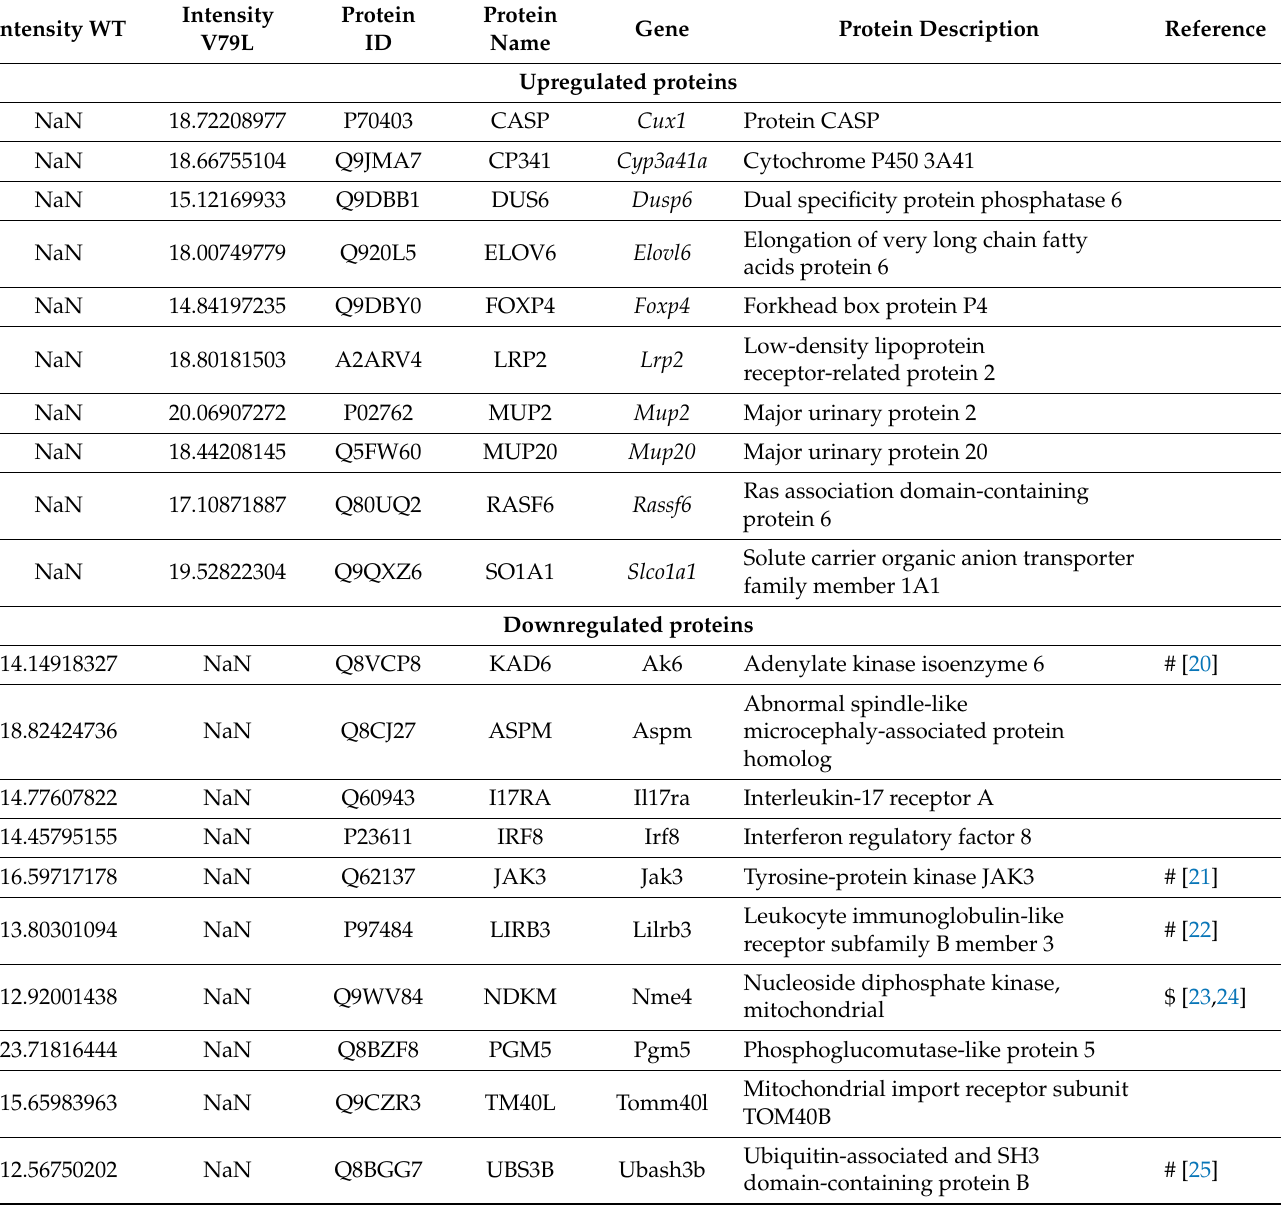
Table 1. List of upregulated and downregulated proteins in IARS1 V79L mice from the proteomic analysis. NaN indicates quantification or identification criteria not reached. # and $ indicate fatty- liver- and mitochondria-related proteins,